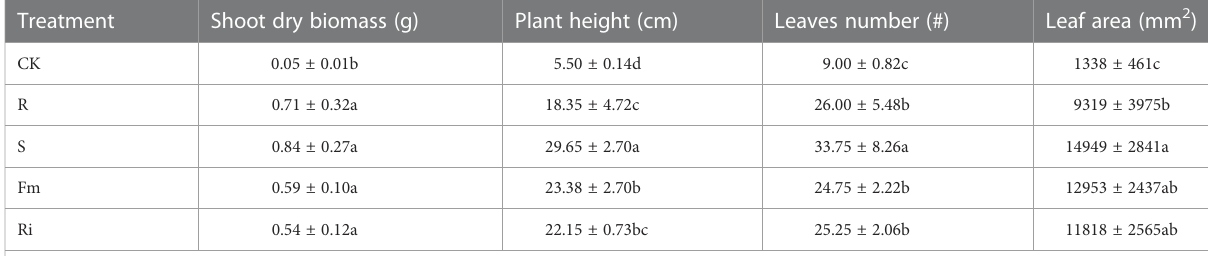
TABLE 2 The effects of indigenous AMF and commercial AMF isolates on growth performance of Pyrus betulaefolia . Treatment